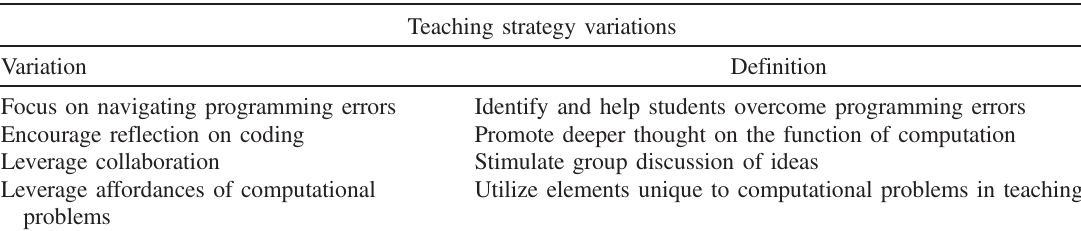
TABLE VII. Variations within the teaching strategy theme, describing the techniques learning assistants use while